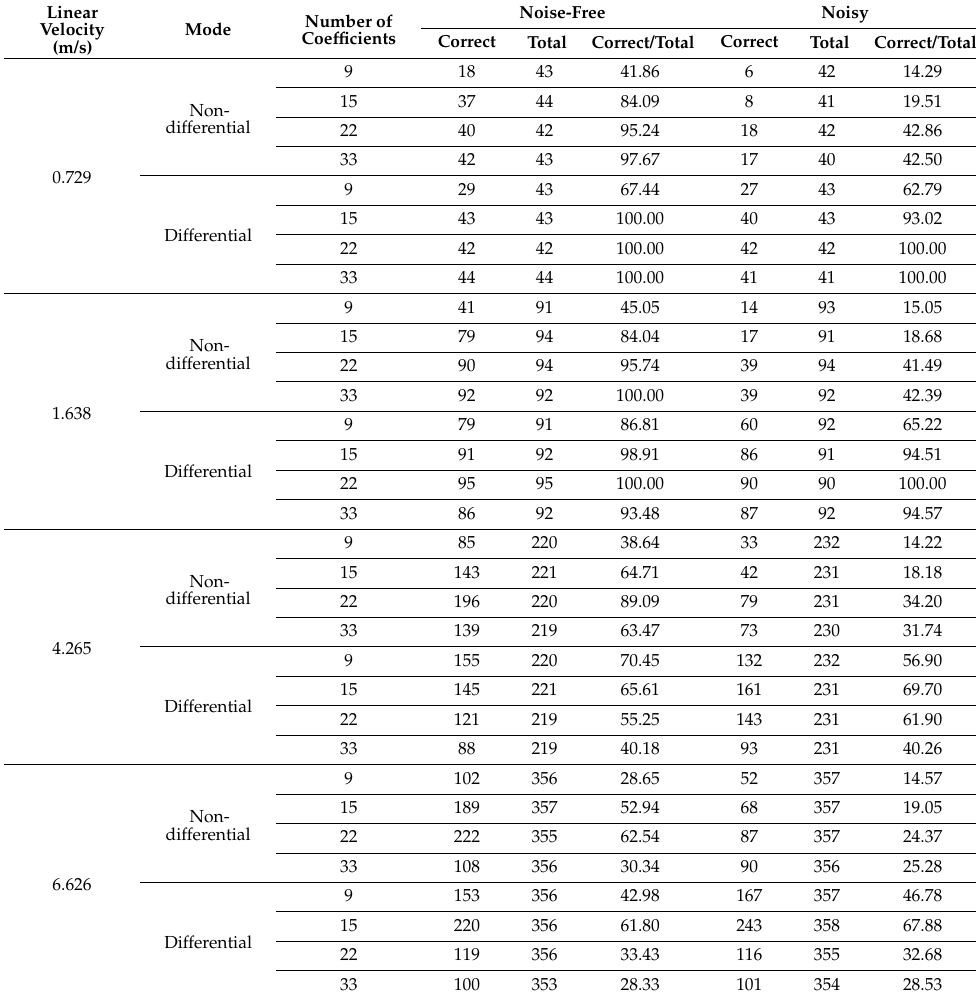
Table 4. Experiment classification results of moving